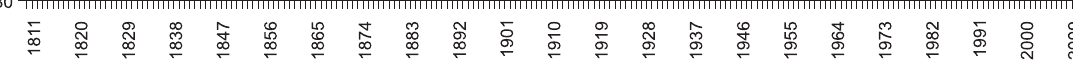
Fig. 8. Changes of the mean sea level in Świnoujście in 1811–2010 (the straight line represents the linear trend; the curve represents the 11-yr moving